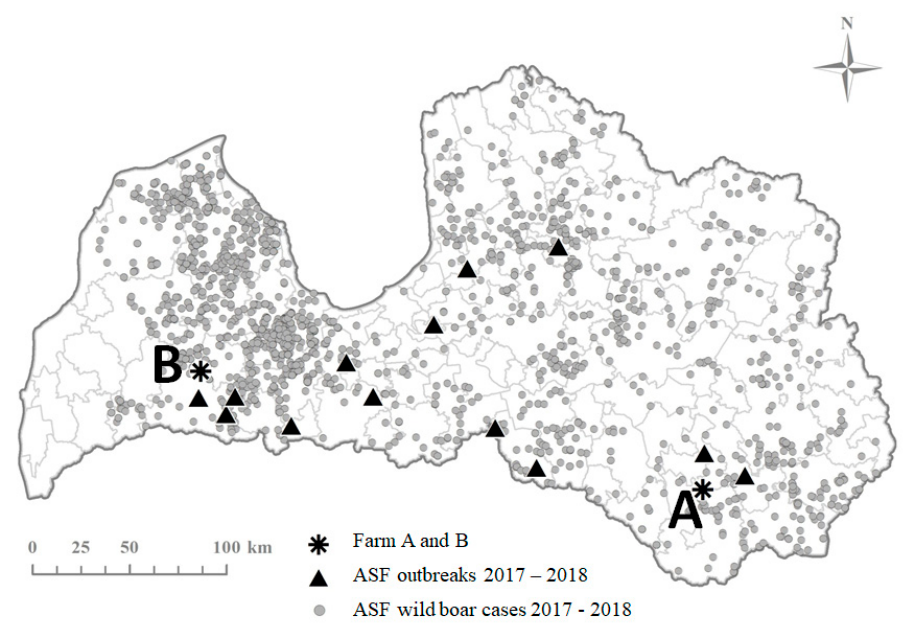
Figure 1. ASF in Latvia in 2017–2018 and the location of the two outbreak farms described in this